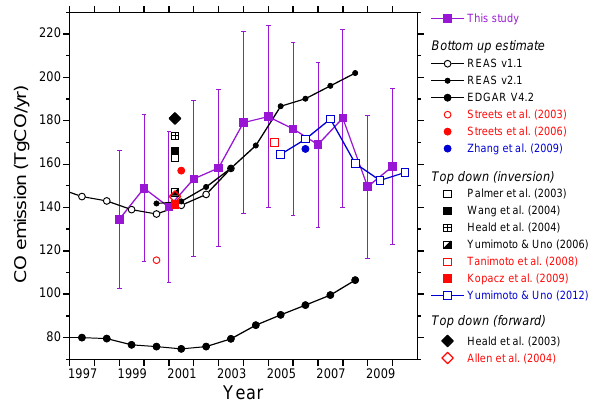
Fig. 10. Comparison of estimated CO emissions from China. The values are expressed as annual emissions. Closed blue squares are the estimated emissions of this study. Circles, squares, and dia- monds represent the bottom-up estimates, top-down (inversion), and top-down (forward) estimates,